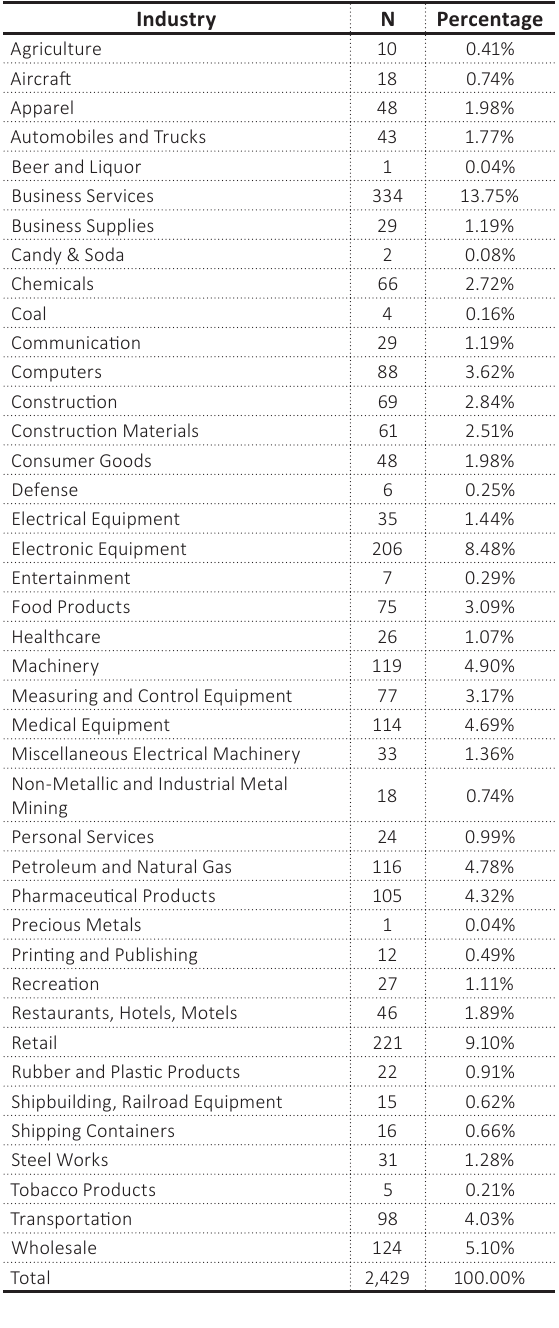
Table 2. Distribution of the sample by industry